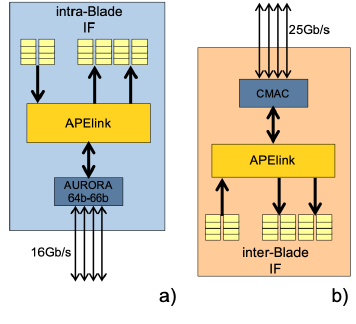
Figure 5. (a) Aurora 64B / 66B-based port; (b) 100 Gigabit Ethernet